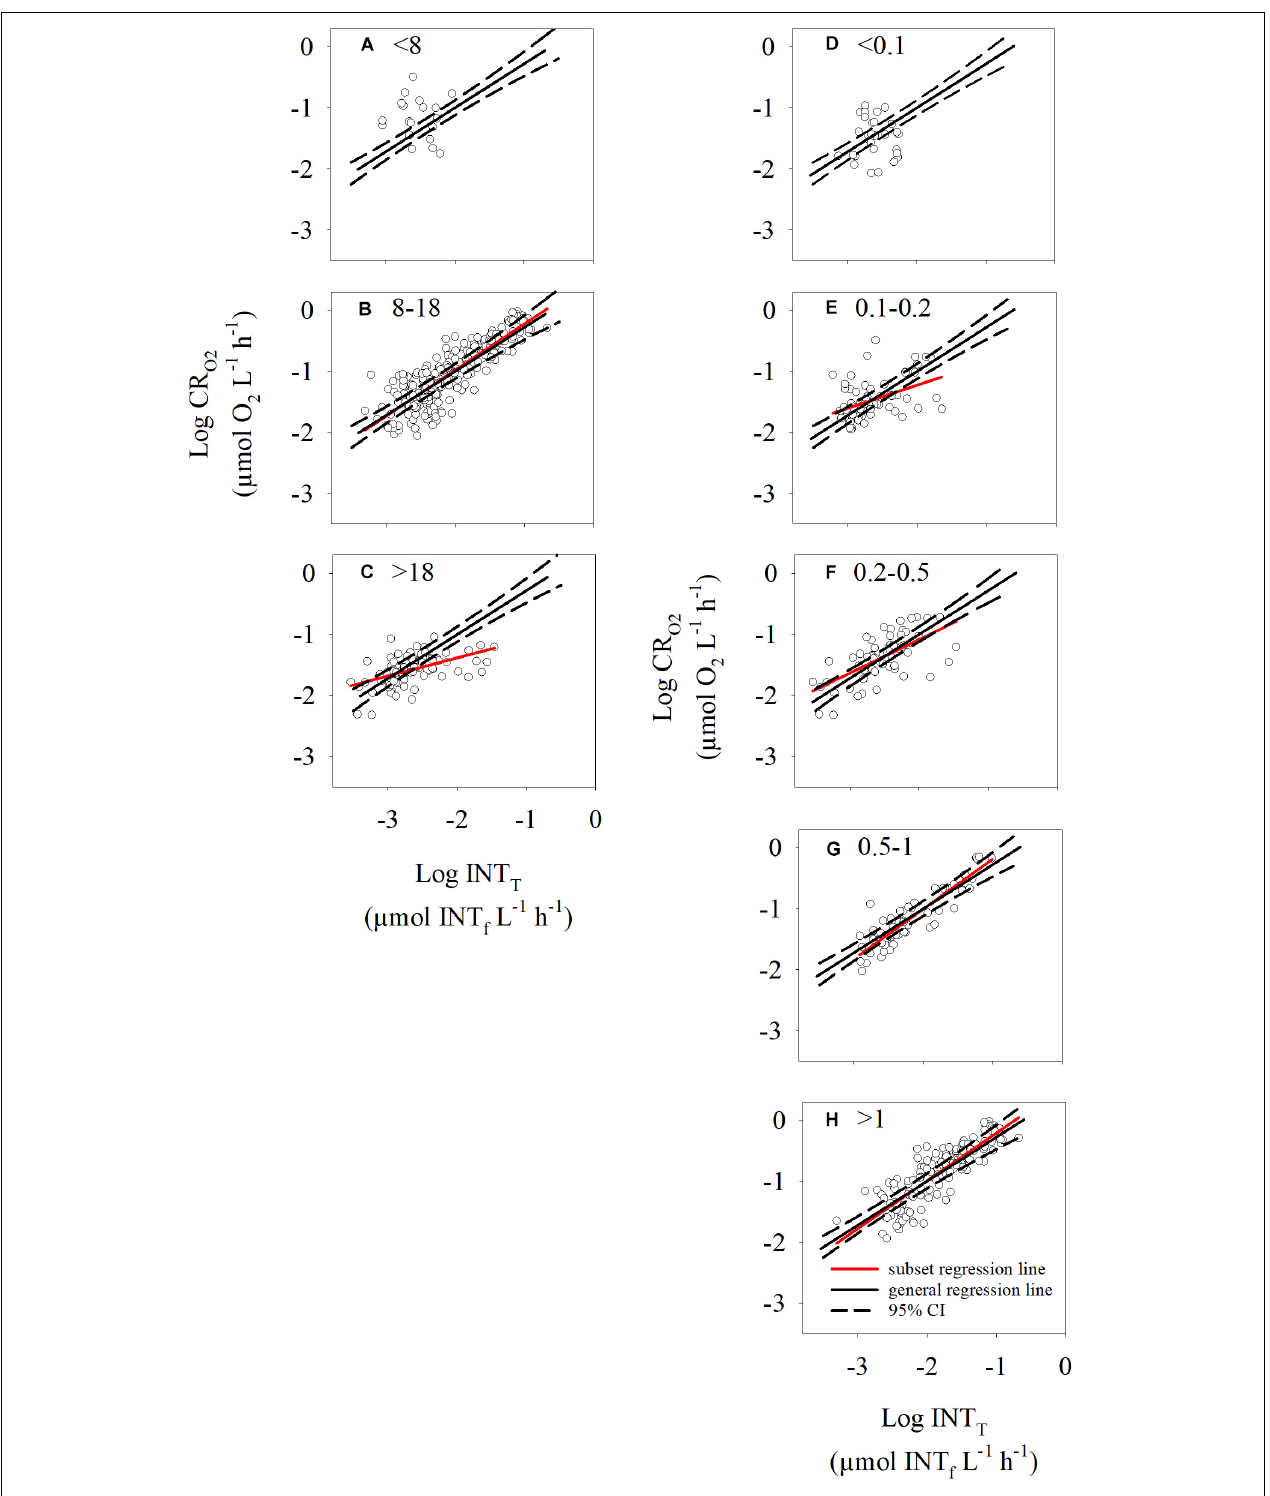
FIGURE 5 | Scatterplots of the log-transformed oxygen consumption and INT reduction rates for the temperature subsets ( < 8, 8–18, > 18 ◦ C) (A–C) and the chlorophyll-a subsets ( < 0.1, 0.1–0.2, 0.2–0.5, 0.5–1, > 1 µ g L − 1 ) (D–H) . The solid line is the overall regression equation obtained in this manuscript (logCR O2 = 0.72logINT T + 0.44) and the black dotted lines indicate the maximum and minimum 95% confidence interval. The red lines are the regression lines obtained for each individual subset of data. Regression lines in panel (A,D) were not plotted, as they were not significant.